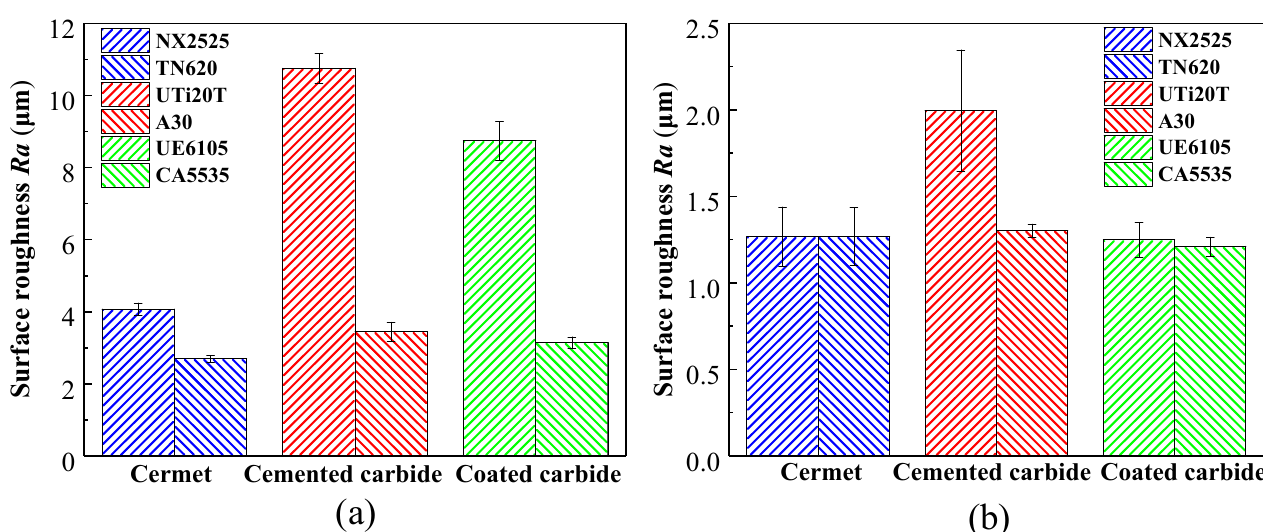
Figure 7. Surface roughness of machined workpieces obtained by each tool at both cutting speeds: ( a ) 40 m/min and ( b ) 80 m/min.